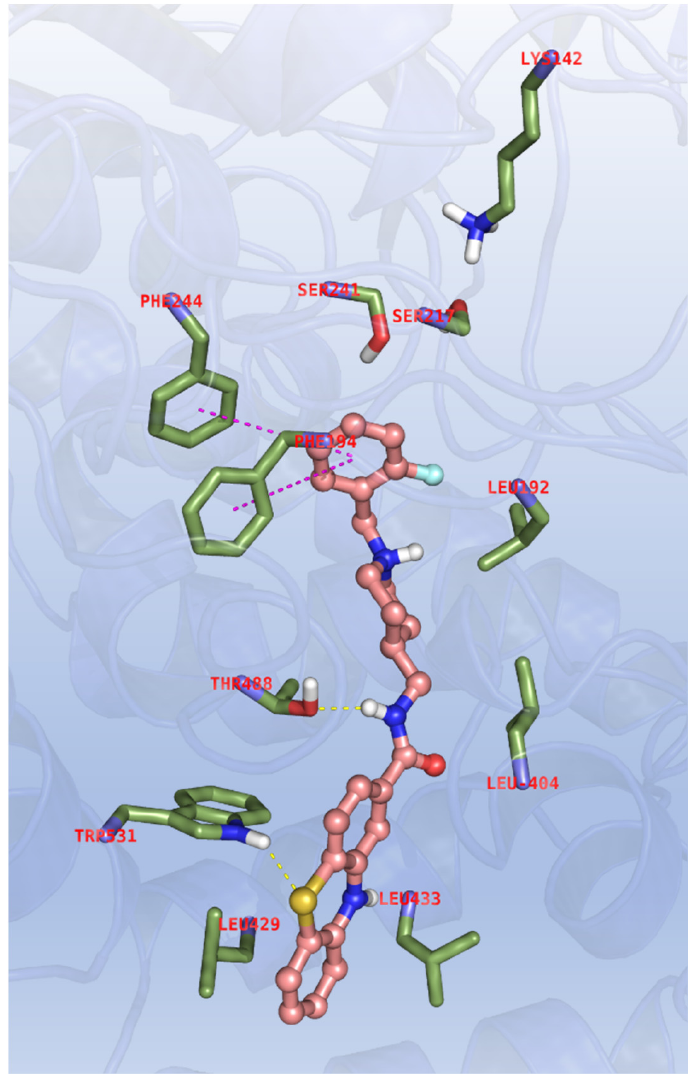
Figure 5. Binding mode for 11d to the FAAH active site. In the interaction pattern scheme hydrogen bonds and π - π stackings are depicted in yellow and magenta, respectively.